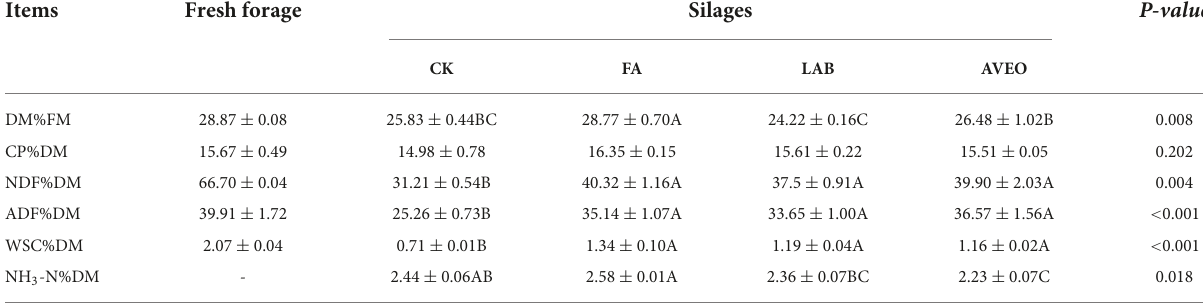
TABLE 1 Chemical composition of fresh material and silage after 60 days of ensiling.